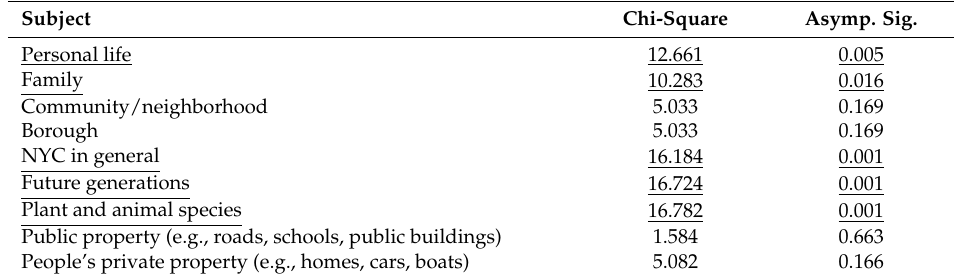
Table 2. Results of Kruskal–Wallis H-Test regarding the sector of future impacts of heat waves. The underlined text shows aspects for which significant differences between income groups exist, i.e., the p-value is lower than 0.05.